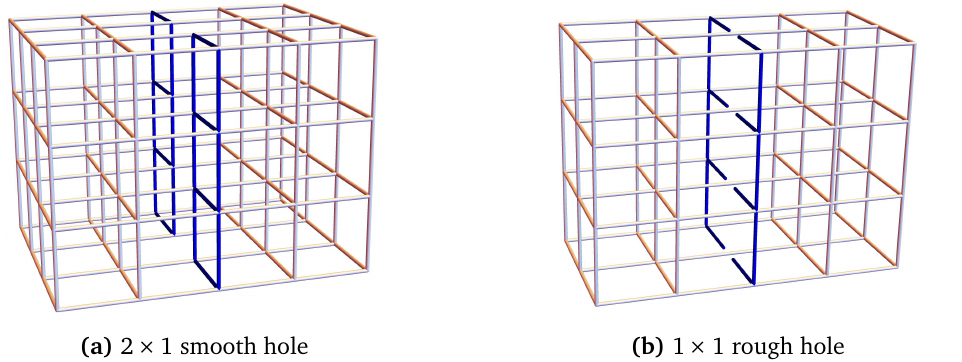
Figure 22: Constructing holes by inserting opposing edge-dislocations (toric code